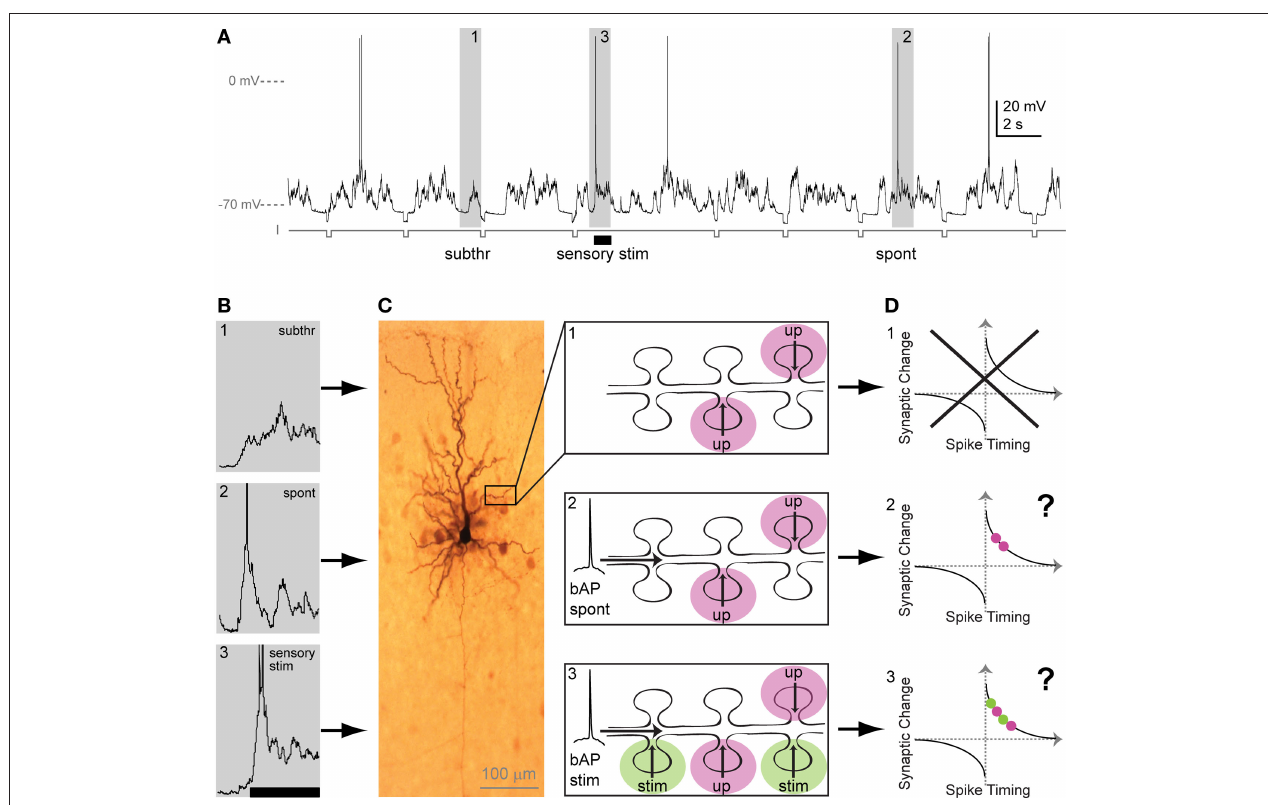
Figure 1 | Sub- and suprathreshold neuronal activity in vivo and putative upstate related synaptic input (up) arrives at dendritic spines. (C ) Spontaneous 2 consequences for STDP. (A) Whole-cell recording from a pyramidal neuron in backpropagating APs (bAP spont) putatively interact with upstate related primary sensory cortex in vivo . Membrane potential trace contains (1) upstates, synaptic input arriving at plasticity-relevant timings. (C ) During sensory 3 generated by presynaptic input, with no APs (action potentials: subthreshold stimulation, stimulus-evoked backpropagating APs (bAP stim) can putatively events; subthr), (2) upstates with spontaneous APs (spont), and (3) upstates interact with upstate related or with stimulus-evoked synaptic input (stim). (D) with APs evoked by sensory stimulation (sensory stim, indicated by bar). Putative changes in synaptic strength based on the timing of the AP with Hyperpolarizing current steps (I) were applied to determine input resistance. respect to incoming synaptic input (for both, upstate-related input [red] and/or (B) Examples of spontaneous and stimulus-evoked activity in vivo . Events stimulus-evoked input [green]). The question arises, if spontaneous bAPs as well marked 1–3 in A (gray boxes) are depicted here in higher magnification. APs are as stimulus-evoked bAPs induce plasticity, when they interact with upstate truncated. (C) Dendritic interactions of presynaptic inputs during both related inputs ( D vs. D ). In addition, the question arises, if both, stimulus- 2 3 subthreshold upstates and suprathreshold upstates with a spontaneous or a evoked and upstate-related input – when timed to coincide with bAPs – induce stimulus-evoked backpropagating AP. Left: Biocytine-stained pyramidal neuron changes in synaptic strength (D ) . Alternatively, in addition to timing, factors may 3 showing soma, dendritic and axonal arborization. Part of the dendrite is shown exist that enable the spatial and temporal selection of activated synapses for schematically in the three panels at the right: (C ) During subthreshold events, 1